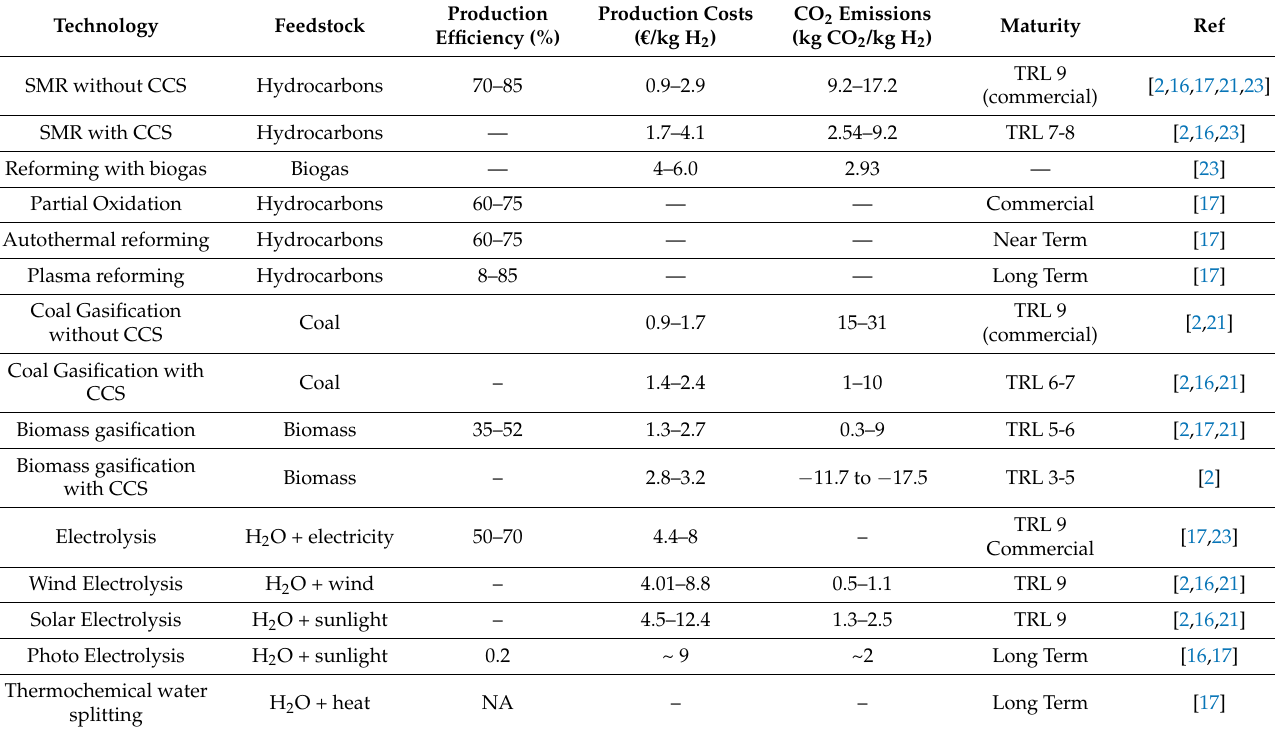
Table 1. H 2 production technologies, costs, efficiency, CO 2 emissions and level of